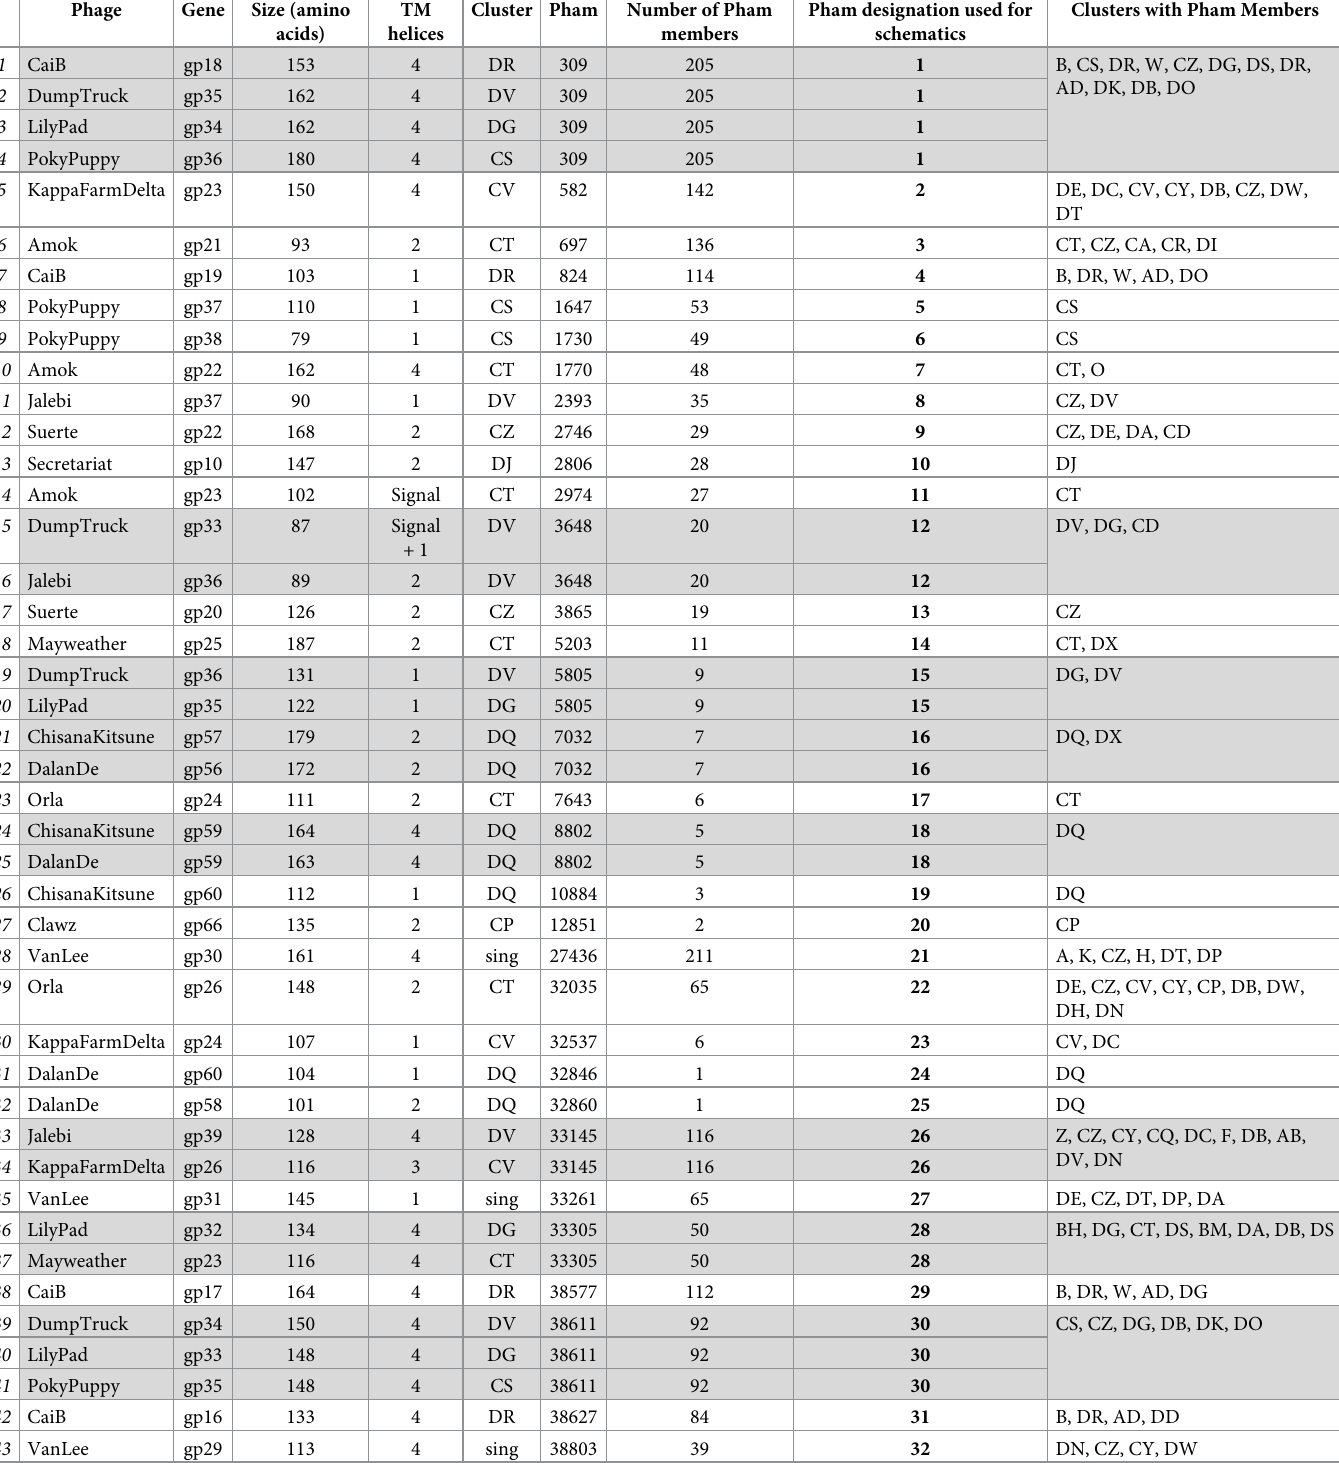
Table 5. TM proteins Identified in 16 reference